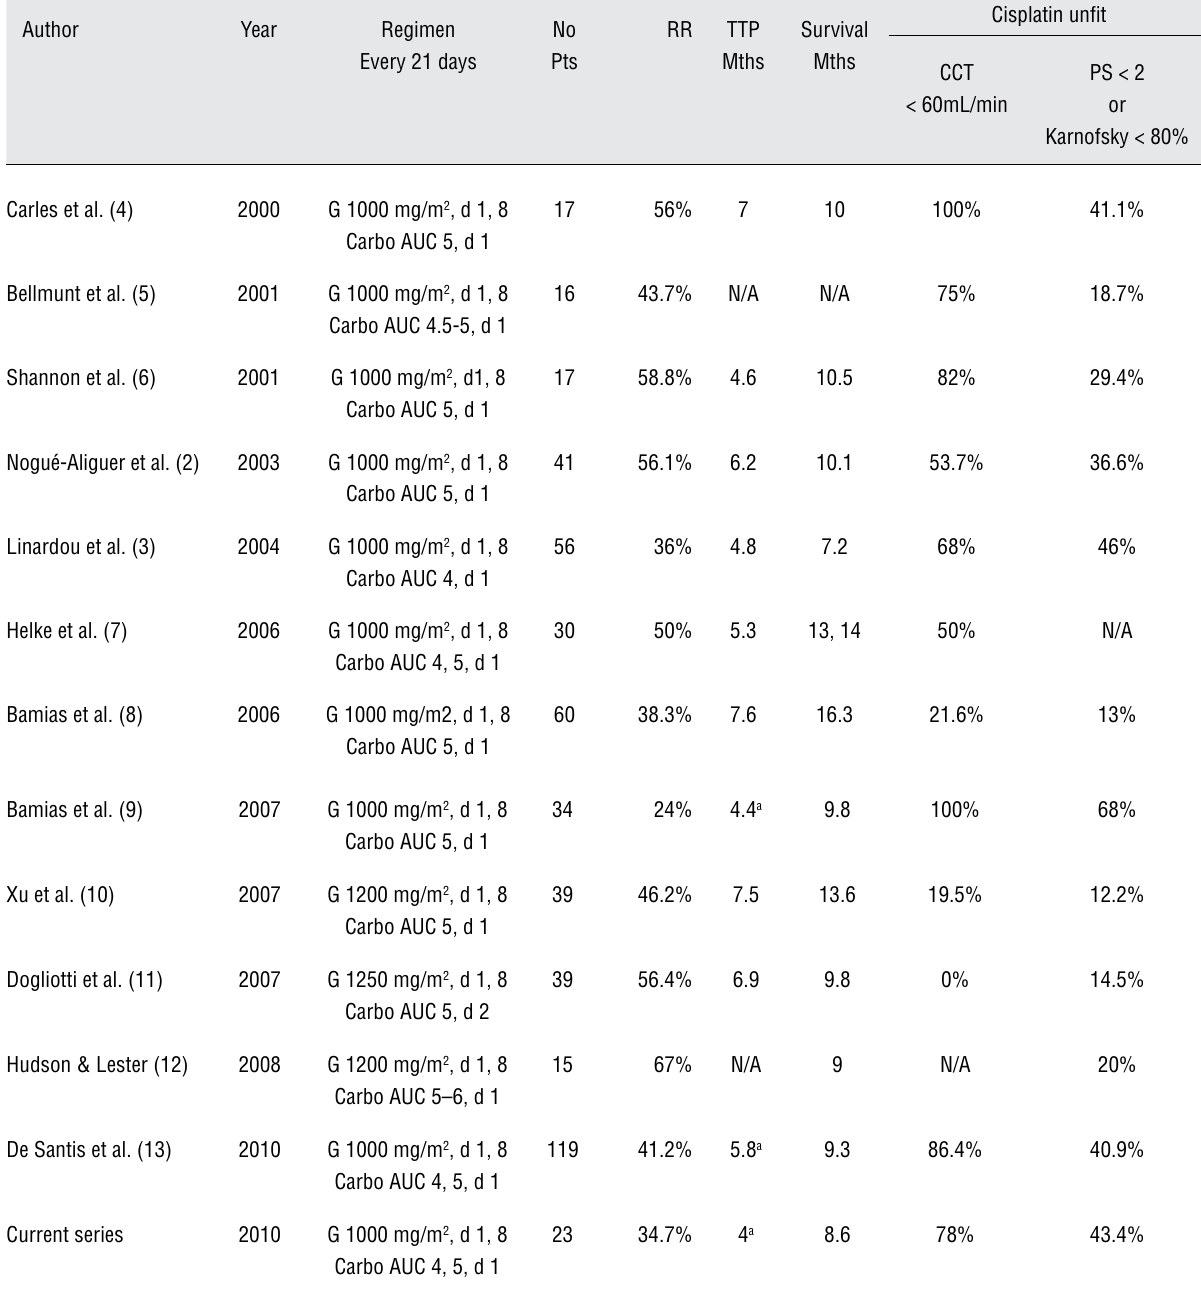
Table 4 – gemcitabine/carboplatin combination in patients with metastatic urothelial cancer unfit for